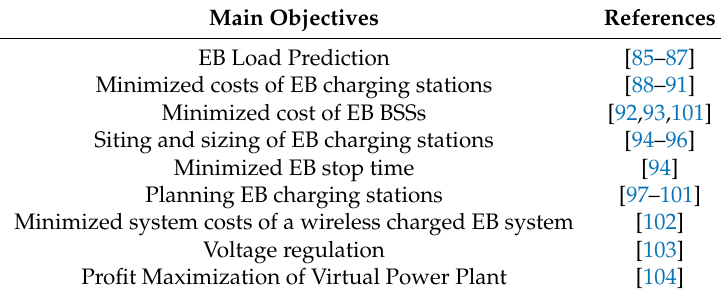
Table 5. Main Objectives of EB-related